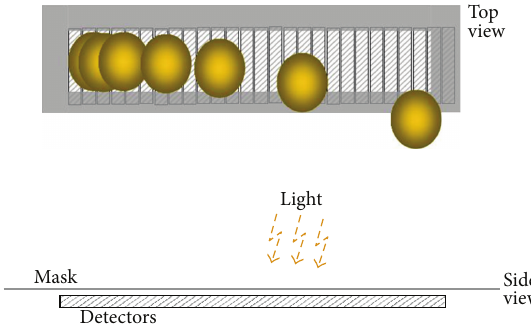
Figure 2: A mask limits the detector area exposed to light.